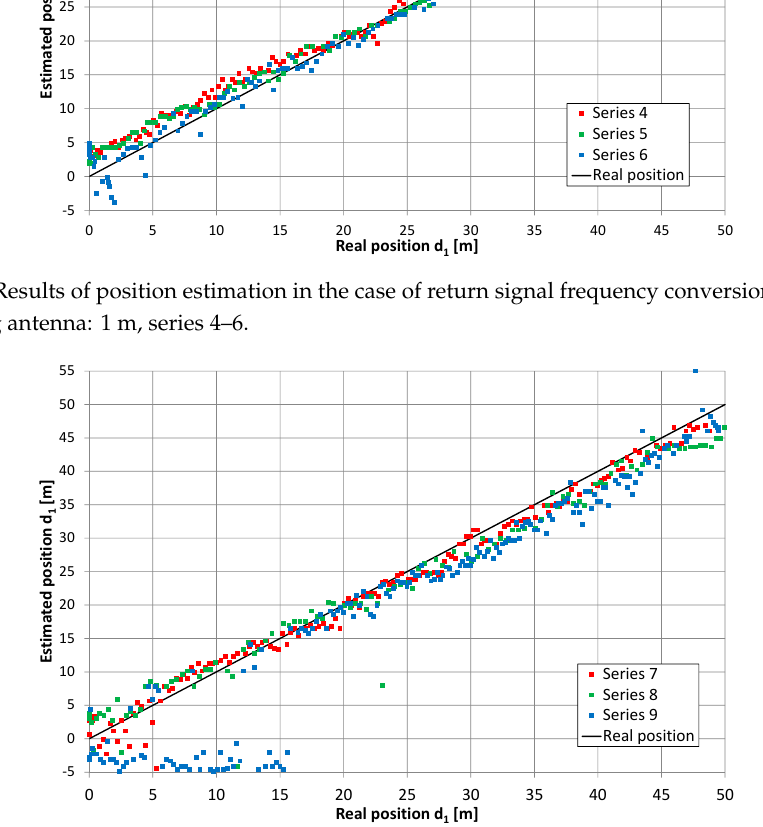
Figure 13. Results of position estimation in the case of return signal frequency conversion; the height of receiving antenna: 0.3 m, series 7–9.